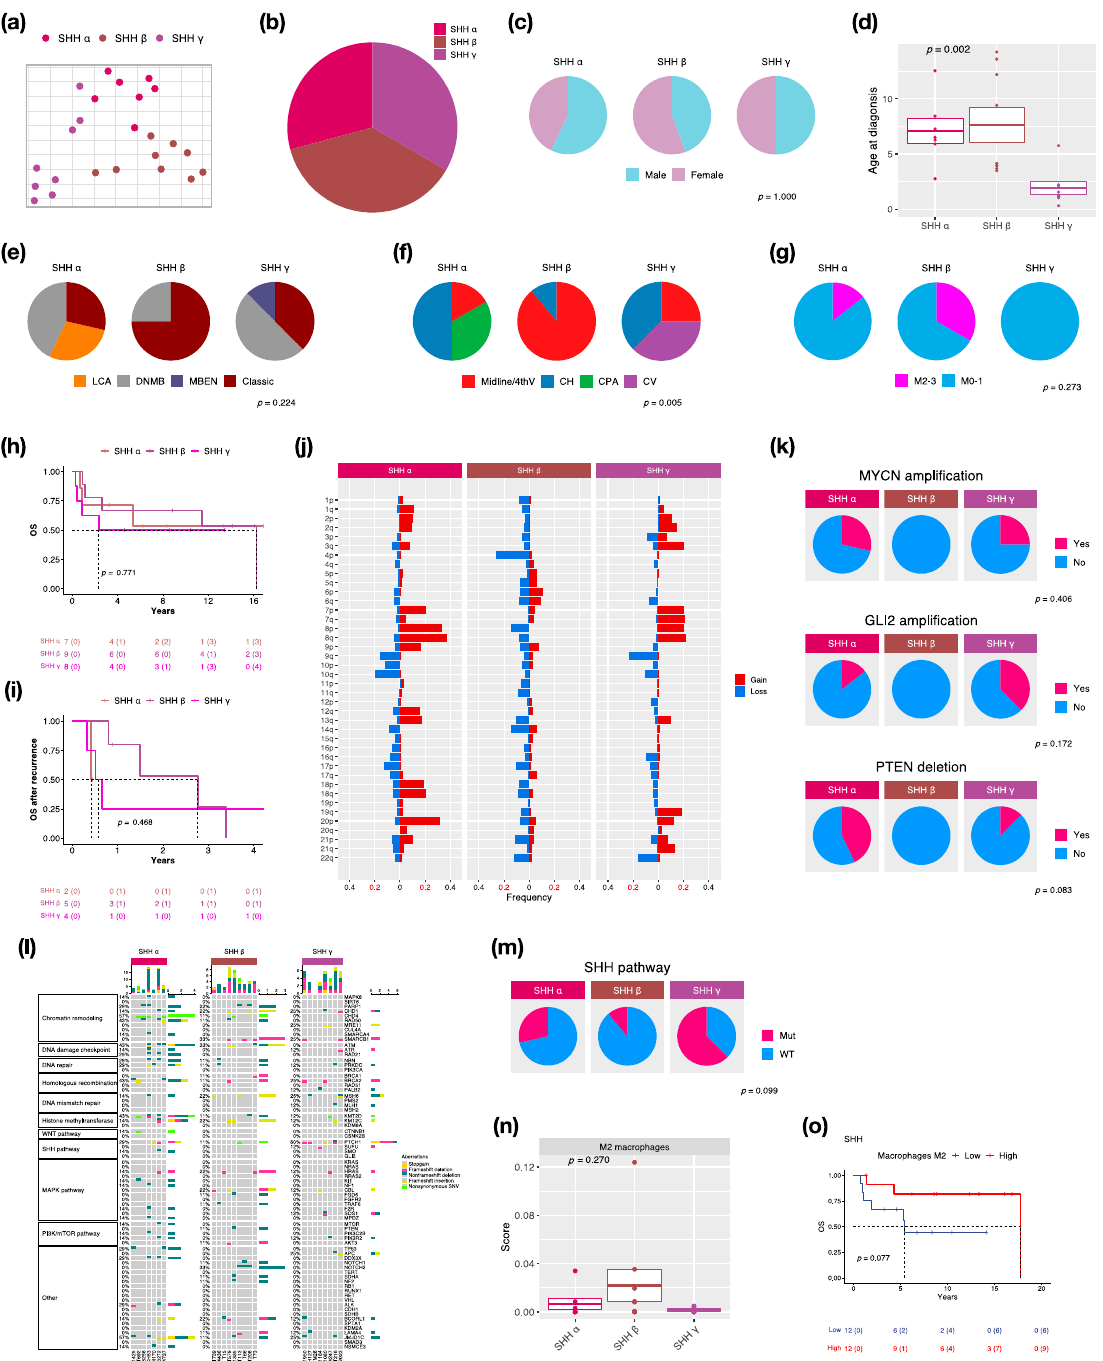
Figure 3. Characteristics in SHH MB subtypes. t-SNE dimensional distribution ( a ) and proportion ( b ) of SHH subtypes. Clinical features including gender ( c ), age ( d ), histology ( e ), tumor location ( f ), metastasis ( g ) in SHH subtypes. DNMB: desmoplastic/nodular medulloblastoma, MBEN: medulloblastoma with extensive nodularity, LCA: large-cell/anaplastic, Midline/4thV: midline of the fourth ventricle, CV: cortex-centered including cerebellar vermis, CH: cerebellar hemisphere, CPA: